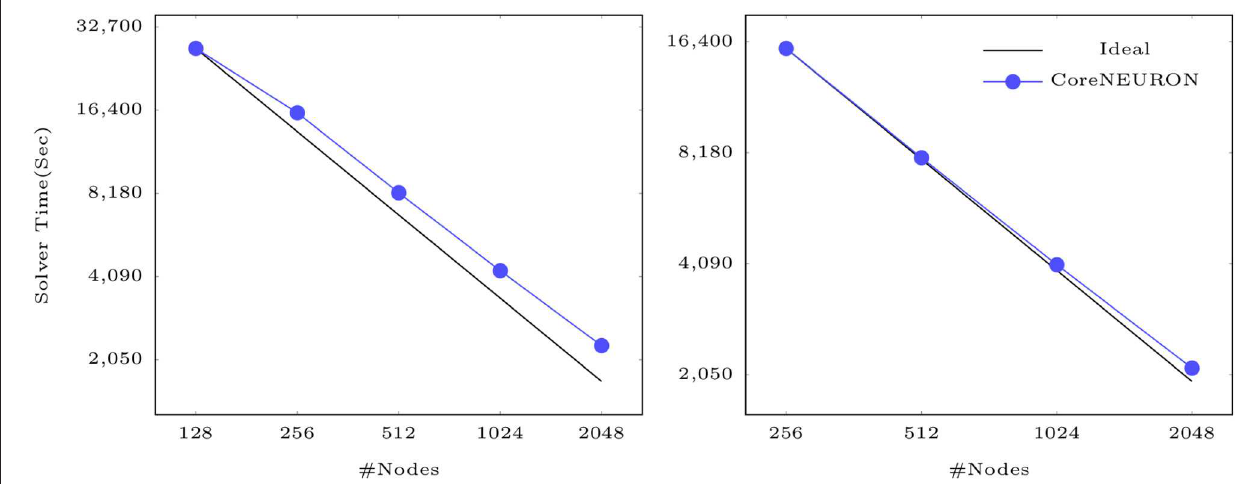
FIGURE 8 | Strong scaling of CoreNEURON on the BB4 system for two large scale models listed in Table 1 : the Cortex+Plasticity model with 219 k neurons (on the left) and the Hippocampus CA1 model with 789 k neurons (on the right).